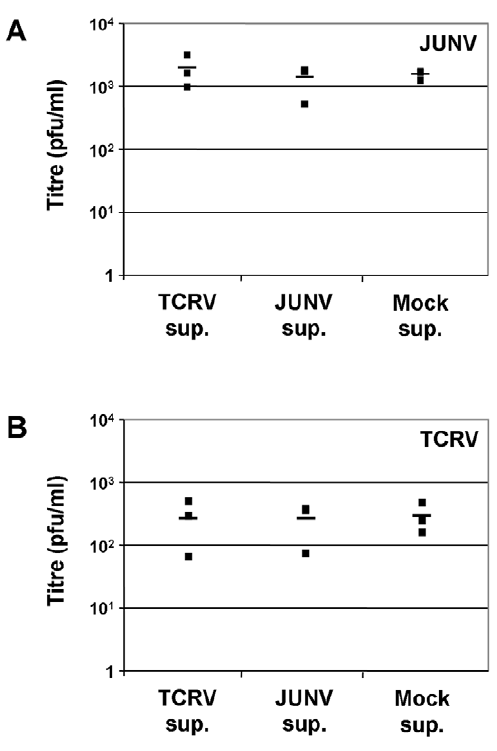
Figure 6. Comparison of virus titre during infection in the presence or absence of cytokine-containing supernatants. Cytokine supernatants collected from primary human monocytes infected at an MOI of 0.1 with either TCRV or JUNV or mock infected at 4 days post-infection were subjected to ultracentifugation to remove virus particles. Macrophage cultures were then pretreated with the clarified supernatant of TCRV, JUNV or mock infected monocytes for 2 h prior to the addition of known amounts of (A) JUNV or (B) TCRV for infection. Samples were collected after 4 days and plaque assays performed to determine virus